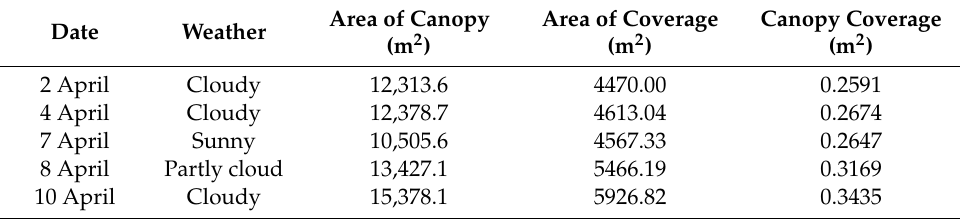
Figure 13. Results of the validation assessment comparing canopy coverage and canopy area. Table 7. Summary of the results including the area of the canopy, the area of coverage, and the canopy